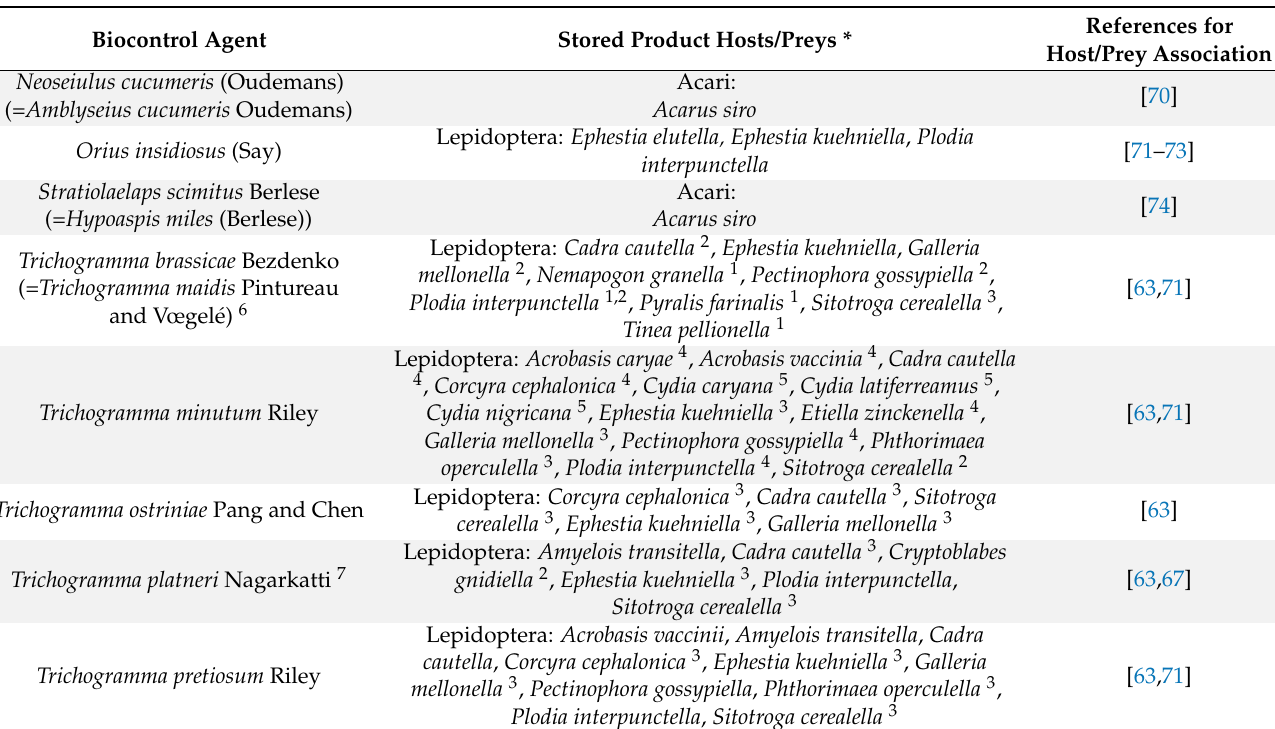
Table 4. Biocontrol agents commercially available in North America that are reported to use pests of stored products as their preys or